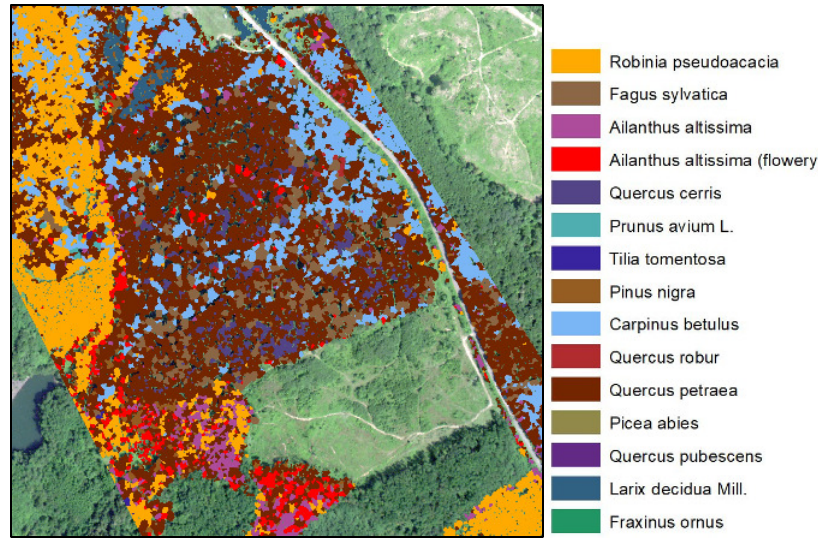
Fig 10: Differentiation of tree types by means of hyper spectroscopy Figure 10 shows the result of a combined hyperspectral and laser data evaluation. The images were taken with an AISA Kestrel10 hyperspectral sensor (1.0m ground pixel) and a Leica ALS70 laser system (8 points/sqm). The use of pixel-based and object-based classification programs allowed the production of a tree species